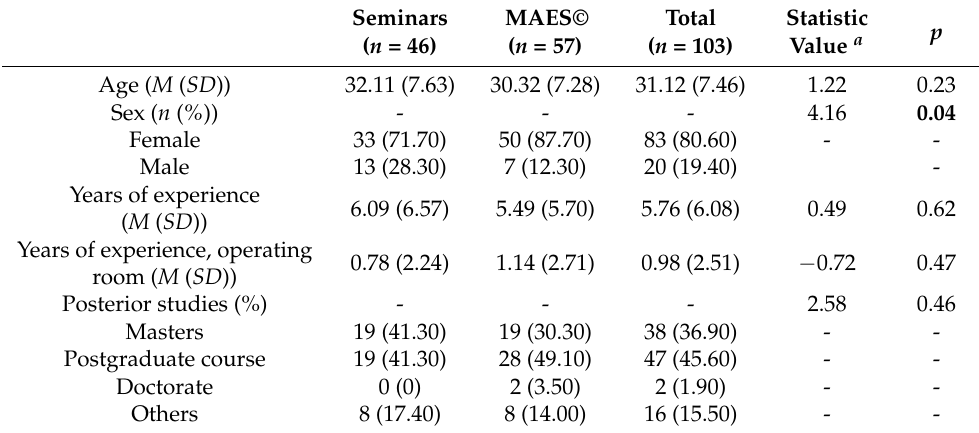
Table 4. Sociodemographic, academic, and professional data of the participants in total and according to the learning methodology